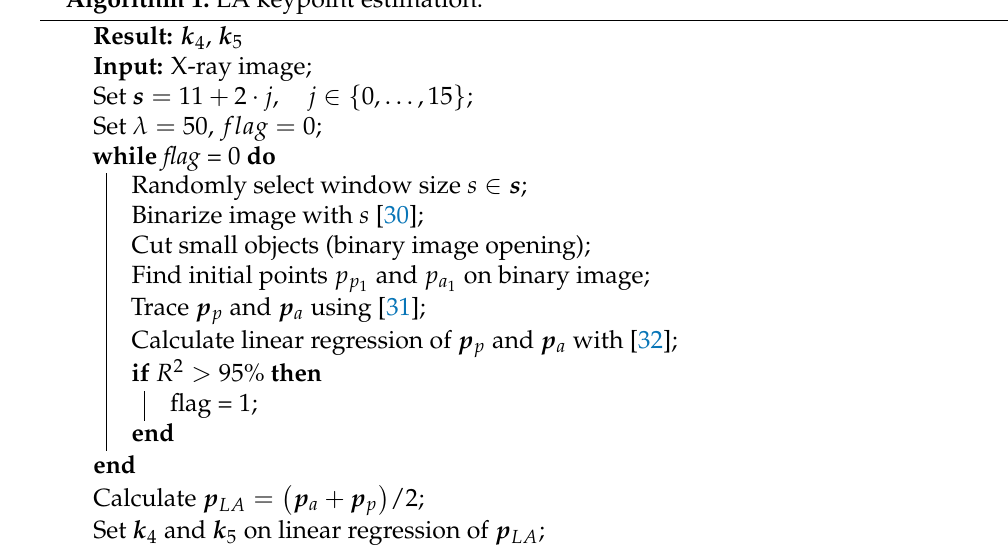
Algorithm 1: LA keypoint